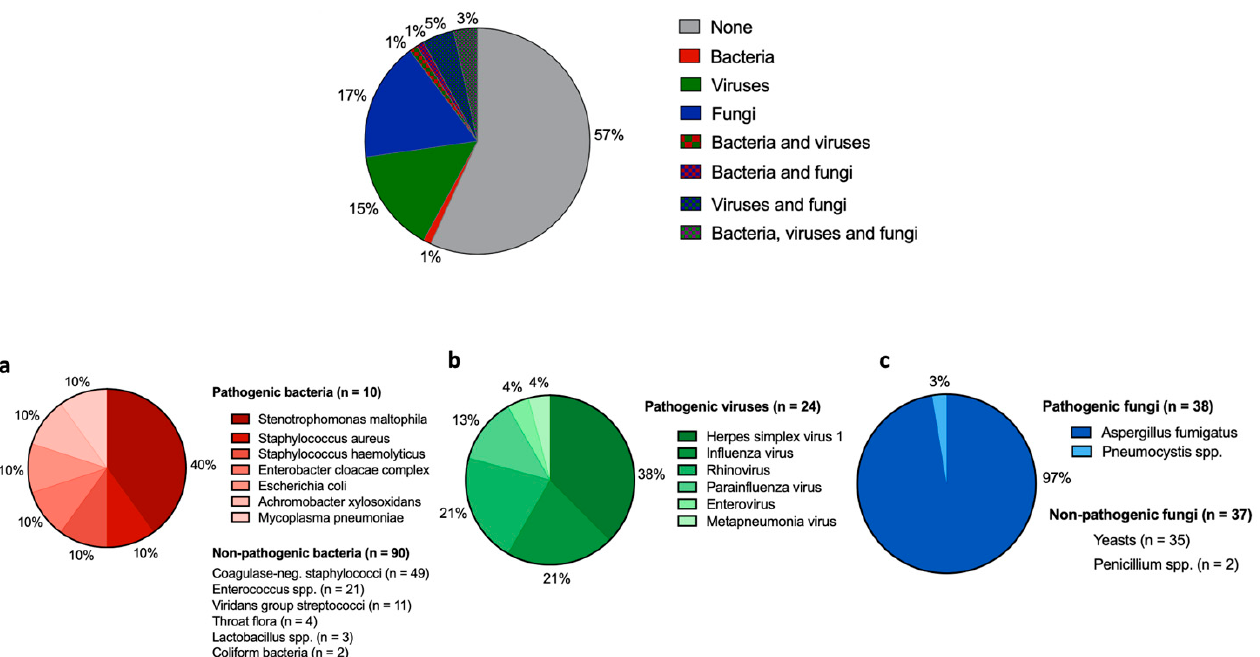
Figure 3. Detection of pathogenic bacteria, viruses, or fungi in bronchoalveolar fluid and distribution of all detected clinically relevant pathogens by showing rates of detection of bacteria, virus, and fungi, or a combination of them in all 88 cases. ( a ) Rate of pathogenic bacteria detected in total of all BAL fluids. Non-pathogenic bacteria are named below but not in the figure. ( b ) Rate of pathogenic viruses detected in total of all BAL fluids. Non-pathogenic viruses were not detected. ( c ) Rate of pathogenic fungi detected in total of all BAL fluids. Non-pathogenic bacteria are named below but not in the figure.